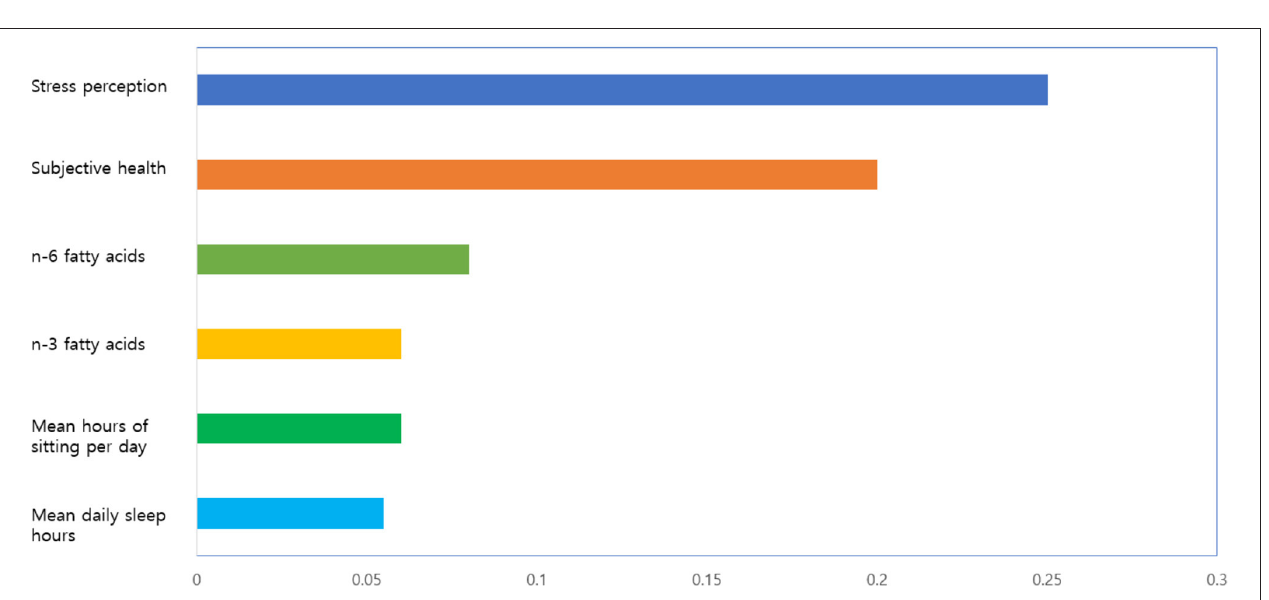
FIGURE 6 | The feature importance (best 6) of final